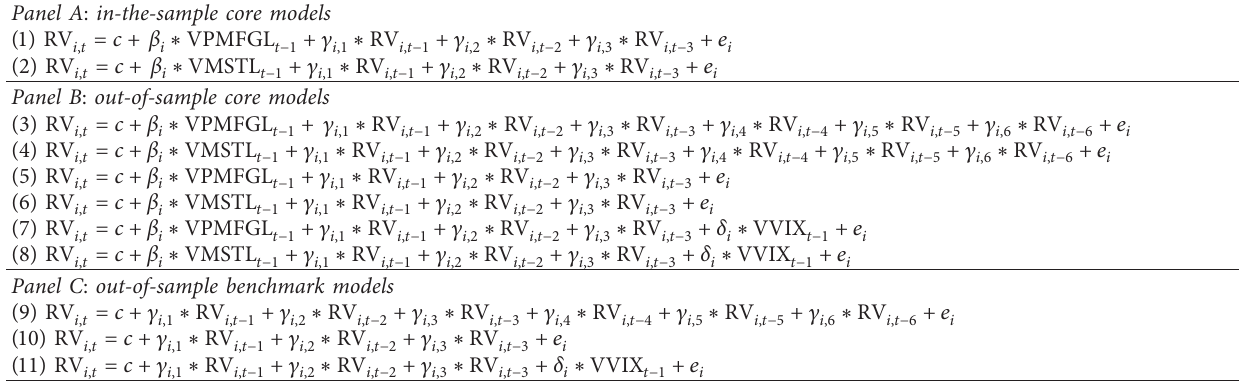
Table 1: The main econometric models for both the core and benchmark models. Panel A : in-the-sample core